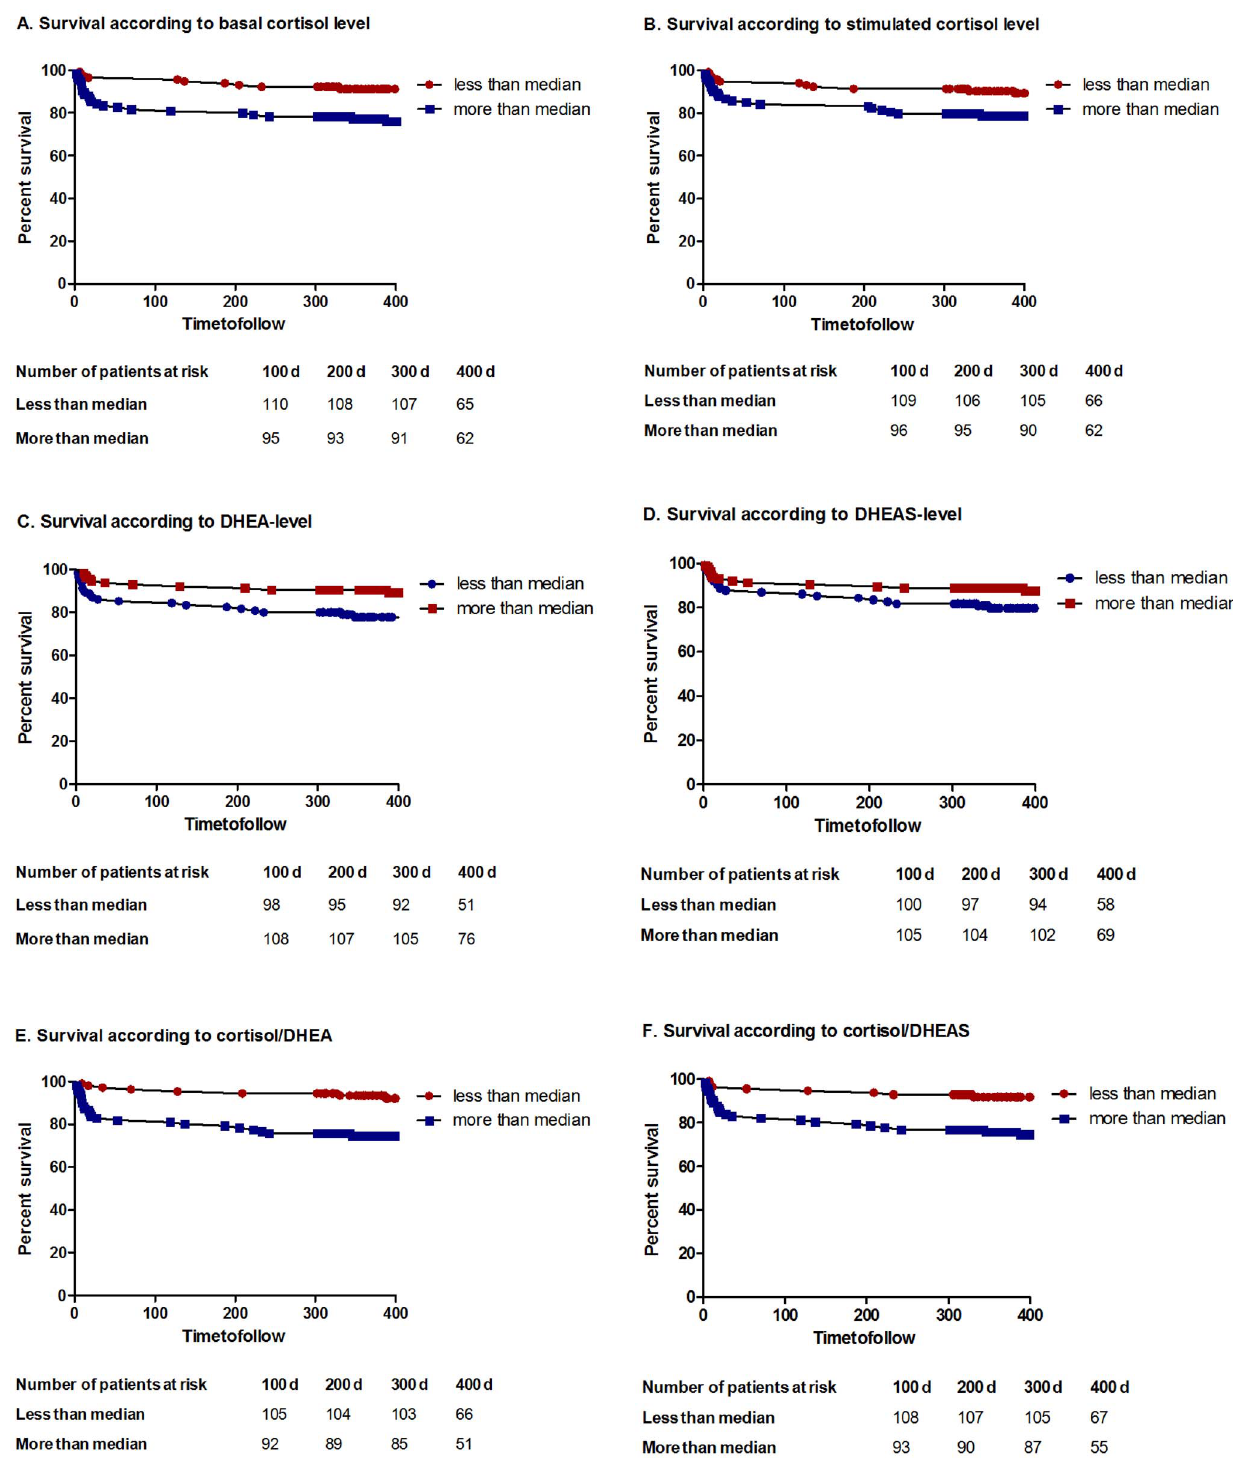
Figure 1. Kaplan Meier Survival Curves. A. Survival in relation to median cortisol level of 475 nmol/L. p=0.0014, Hazard Ratio 0.35, 95% CI 0.19– 0.67. B. Survival in relation to median stimulated cortisol level of 742 nmol/L. p=0.015, Hazard Ratio 0.4496, 95% CI 0.24–0.86. C. Survival in relation to median dehydroepiandrosterone level of 15.5 nmol/L. p=0.0236, Hazard Ratio 2.09, 95% CI 1.104 to 3.955. D. Survival in relation to median dehydroepiandrosterone-sulfate level of 2.4 umol/L. p=0.1490, Hazard Ratio 1.60, 95% CI 0.85–3.80. E. Survival in relation to median cortisol/DHEA level of 27 nmol/nmol. p=0.0002, Hazard Ratio 0.32, 95% CI 0.17–0.61. F: Survival in relation to median cortisol/DHEAS level of 203 nmol/micromol. p=0.0004, Hazard Ratio 0.31, 95% CI 0.17–0.59.